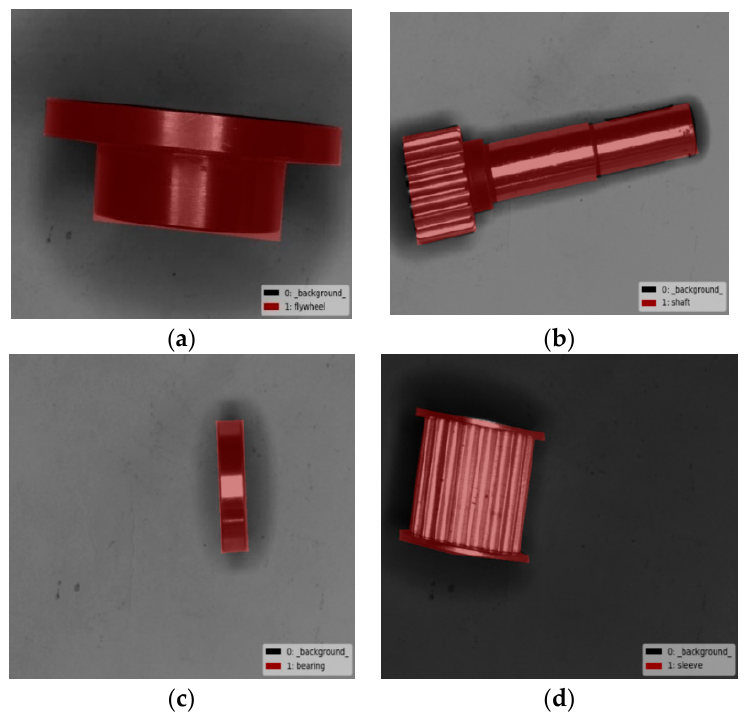
Figure 9. Some examples of annotated training images.